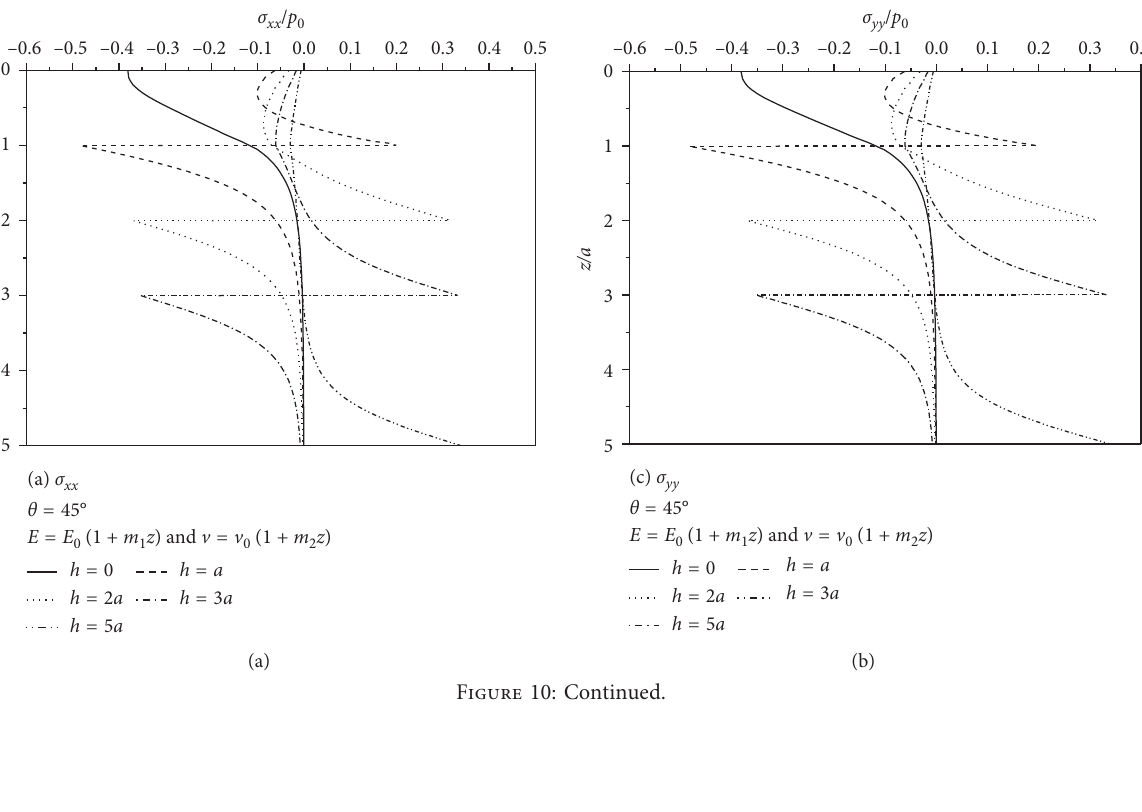
x E 0 / pa ; (b) u z E 0 / pa